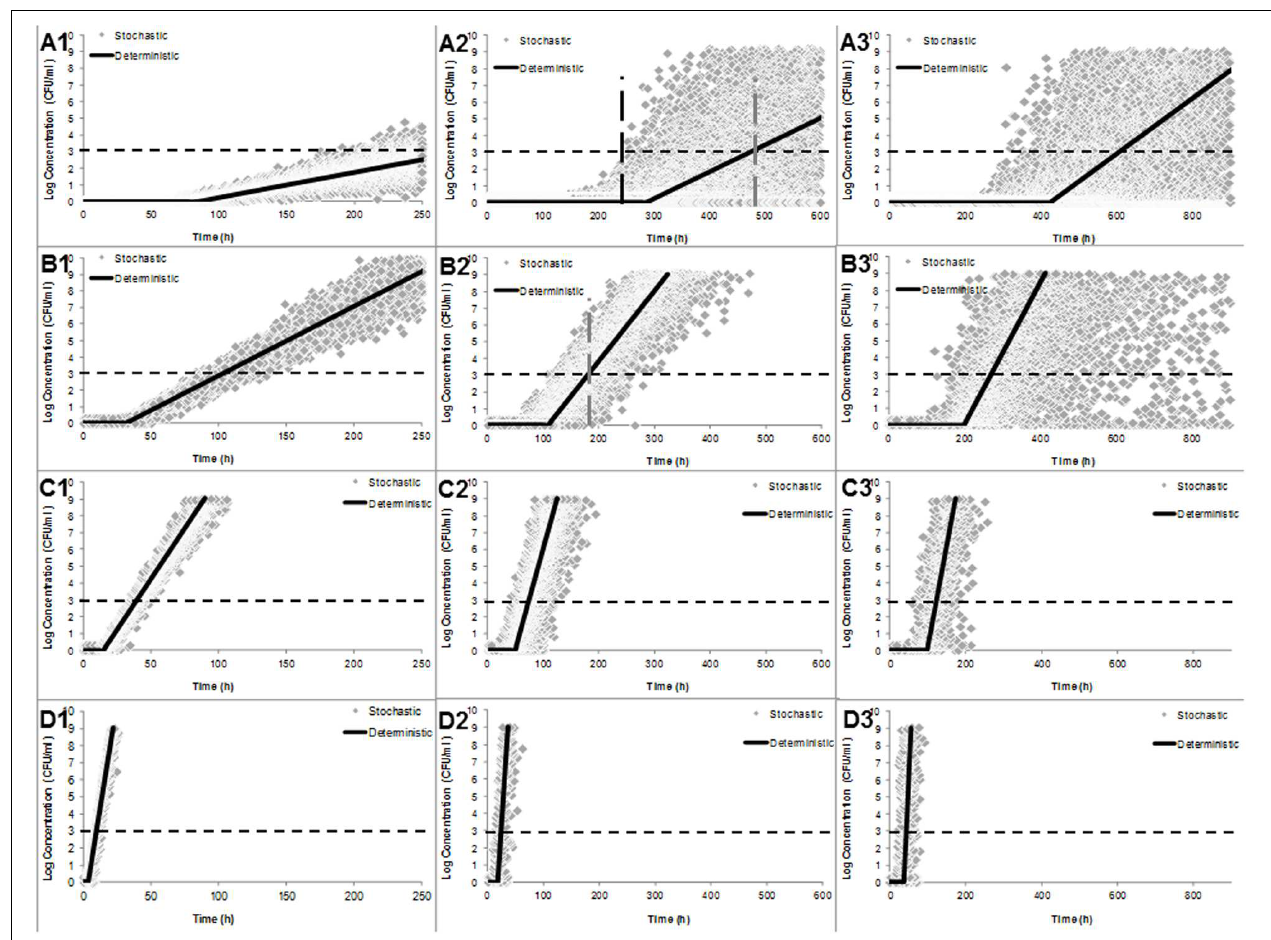
FIGURE 3 | Simulation output of stochastic (gray diamonds) and deterministic (continuos black lines) growth models of an individual C. sakazakii at 5 (A), 10 (B), 15 (C), and 25 ◦ C (D) and treated with 50 ◦ C by 0, 5, and 10 min (numbers 1, 2, and 3, respectively). Discontinuous vertical lines (A2) represent the time at which deterministic and stochastic models reach the concentration of 10 3 CFU/ml. Stochastic predictions for the growth of a single cell using Monte Carlo simulation with 10,000